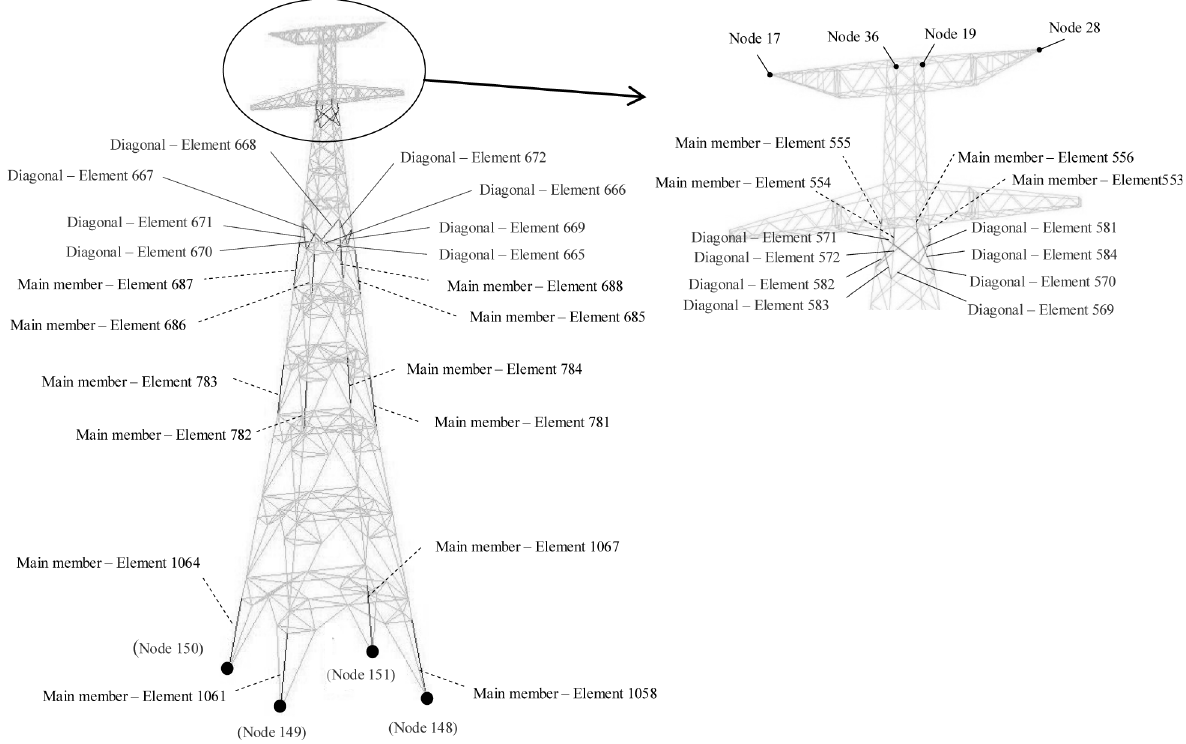
Fig. 6. Selected diagonal and main members of the inferior part of the tower GTS 01